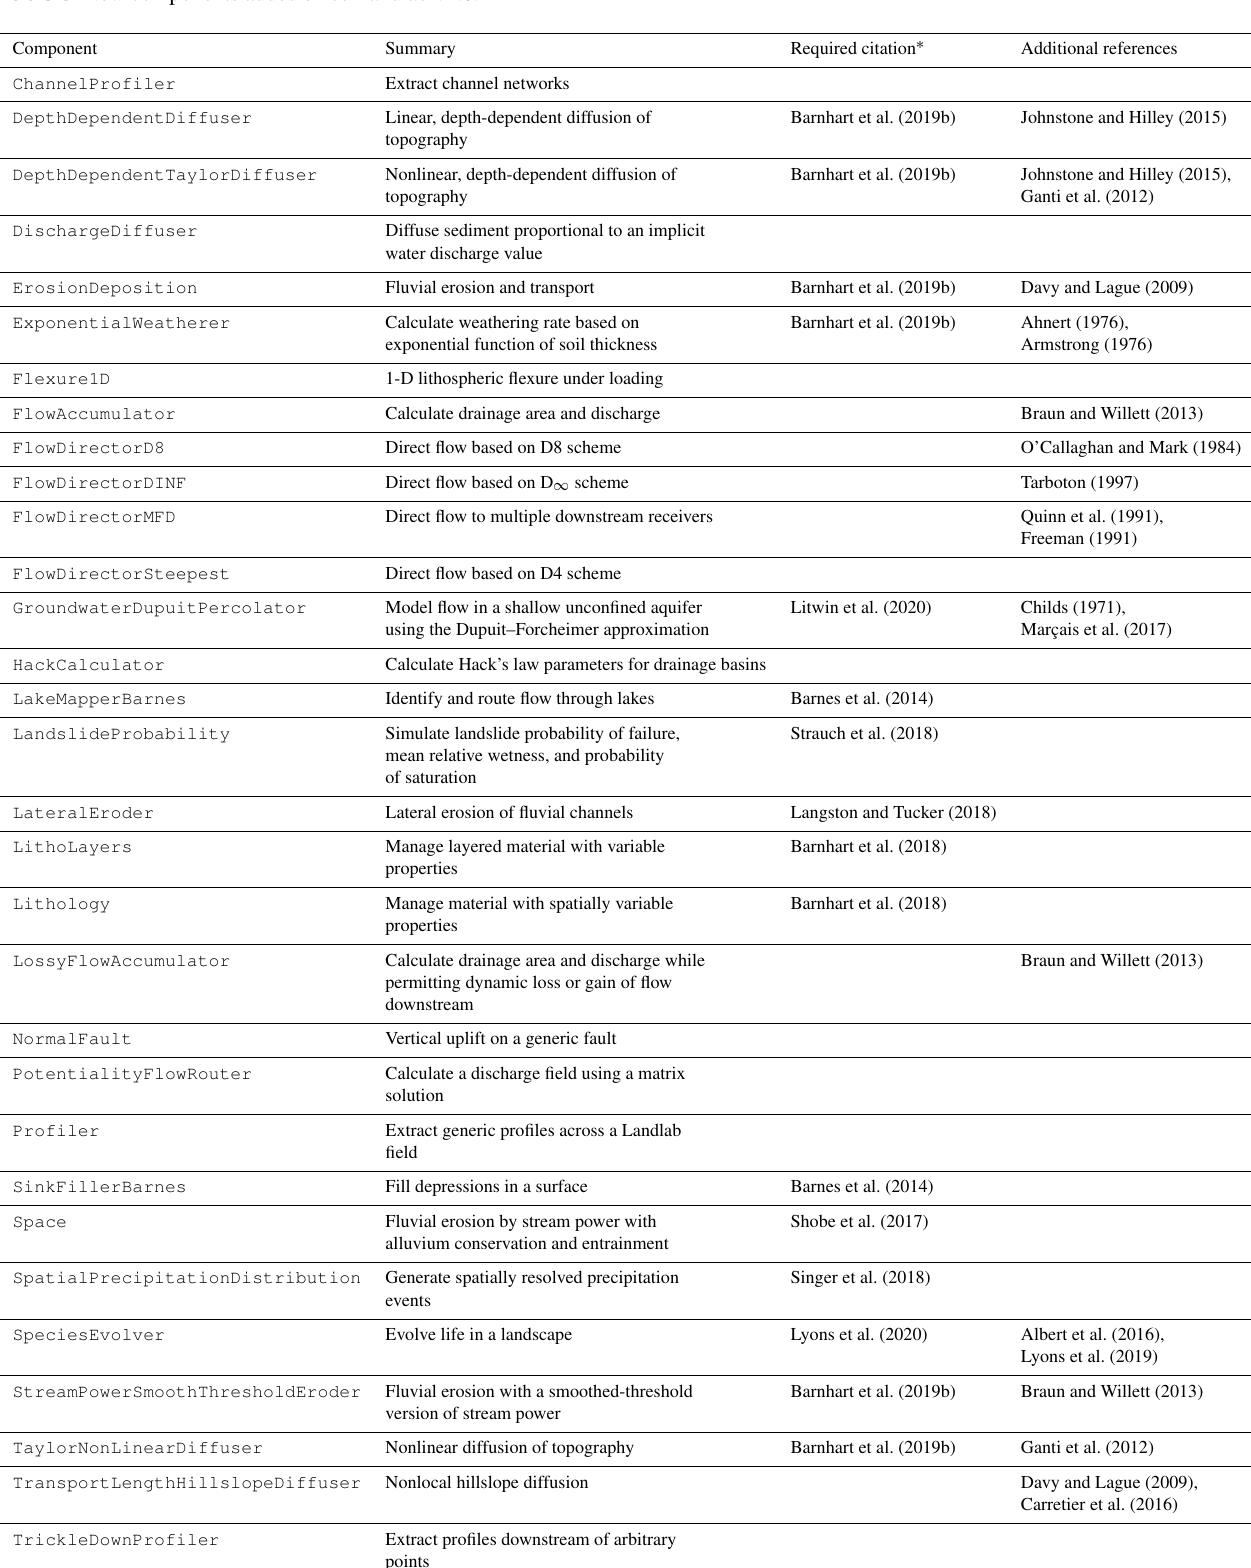
Table 3. New components added since Landlab